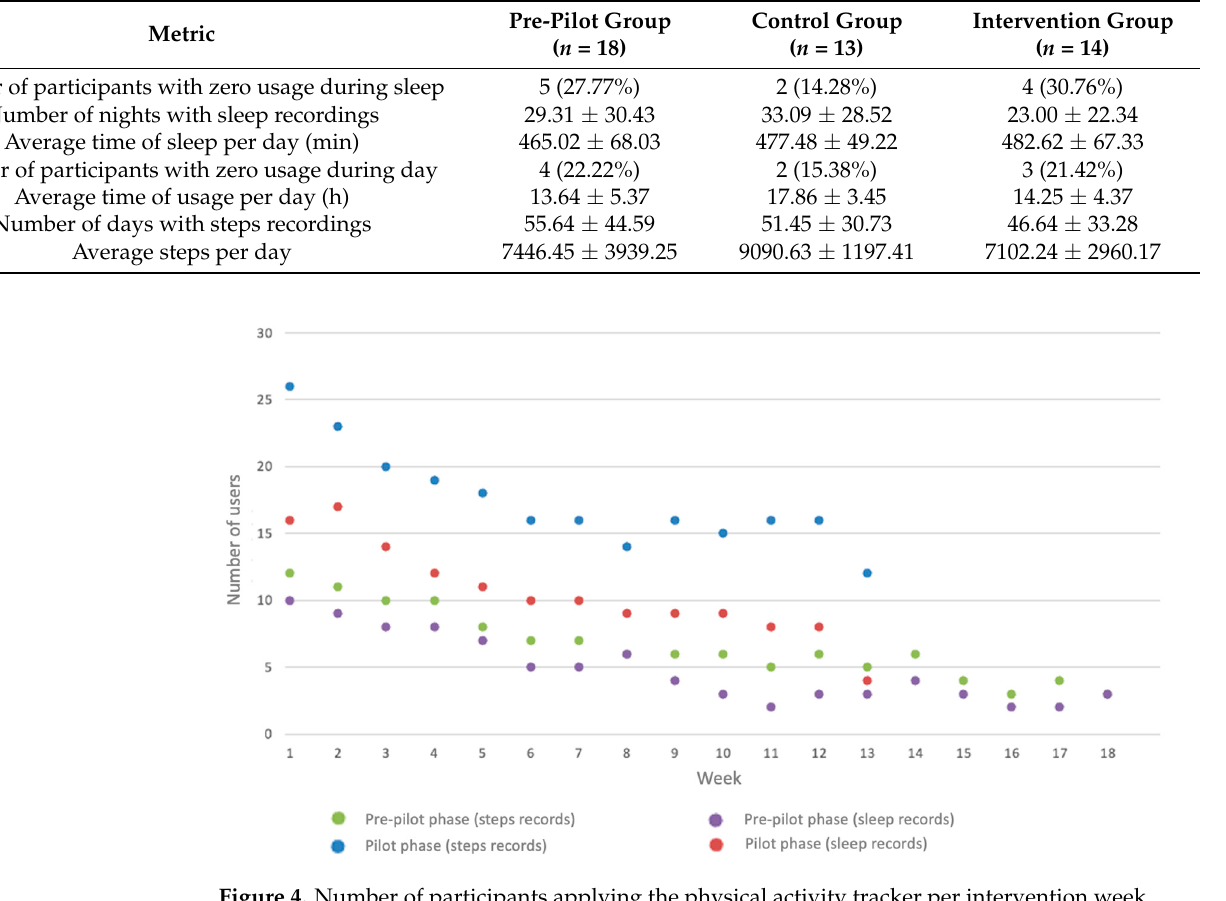
Figure 4. Number of participants applying the physical activity tracker per intervention week.